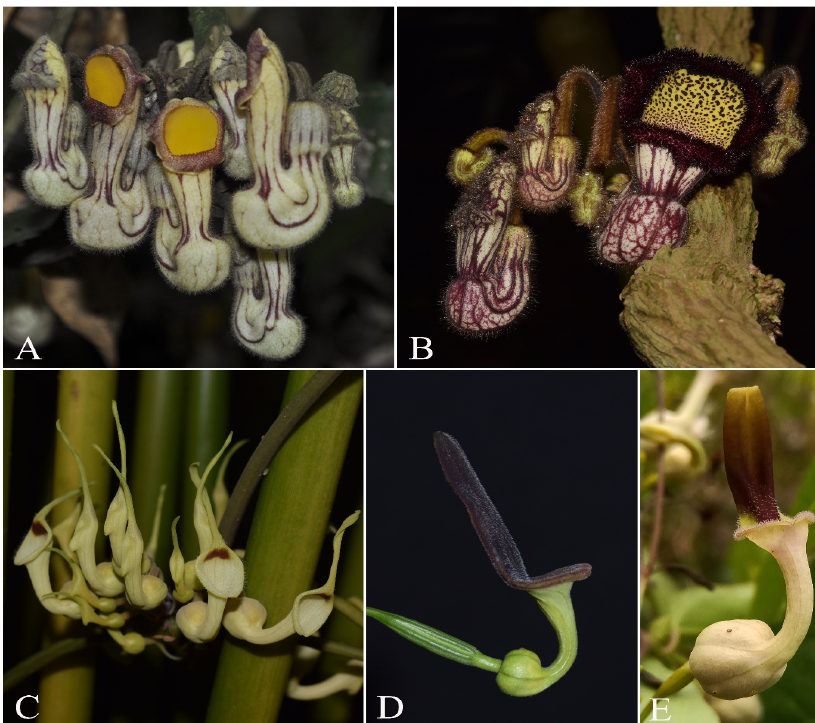
Figure 1. Aristolochia species distributed in Assam: A. A. platanifolia , B. A. cathcartii , C. A. assamica , D. A. acuminata , E. A. indica (A by Khyanjeet Gogoi, B-D by Dipankar Borah & E by Goutam